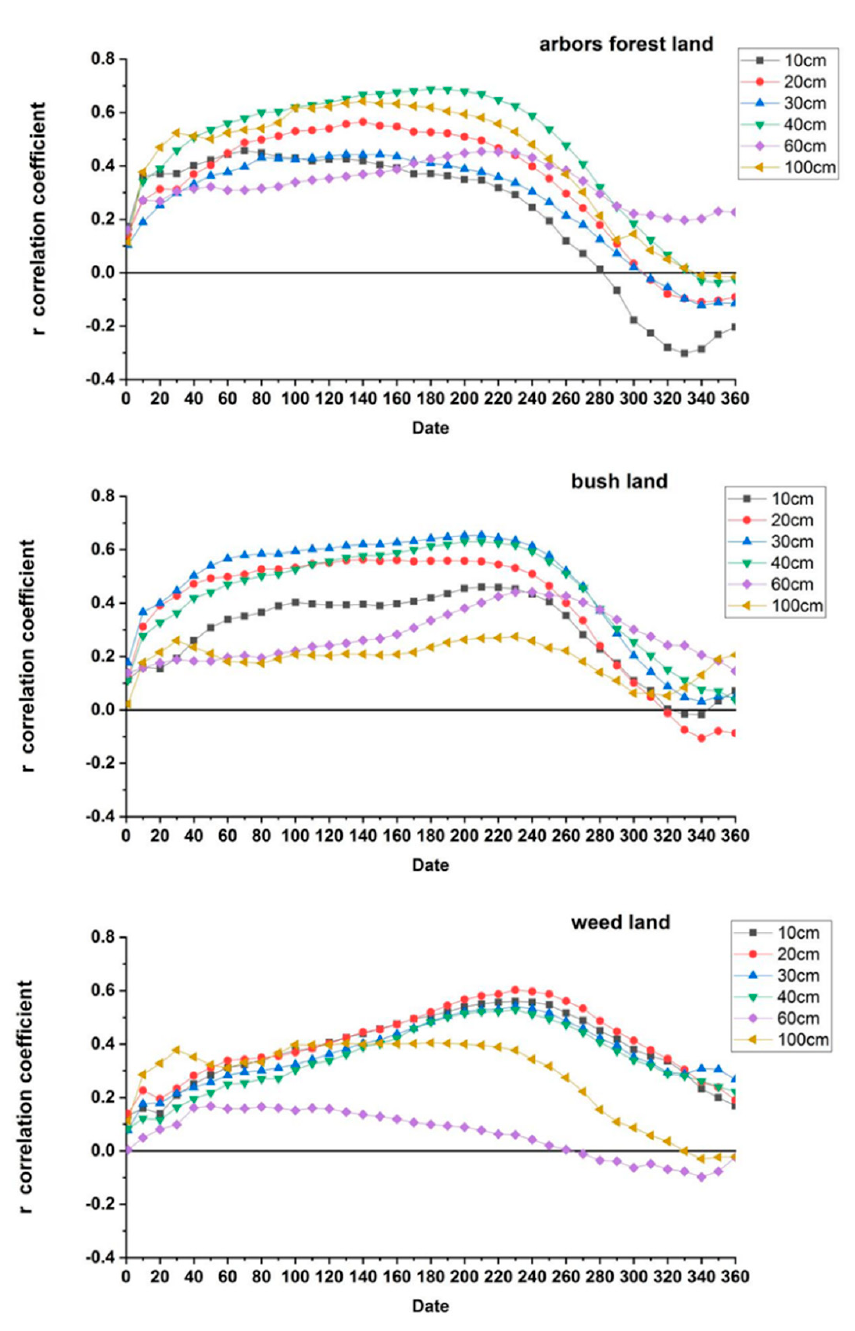
Figure 11. Pearson’s coefficient r between accumulated precipitation and soil moisture content at different soil depths for three site